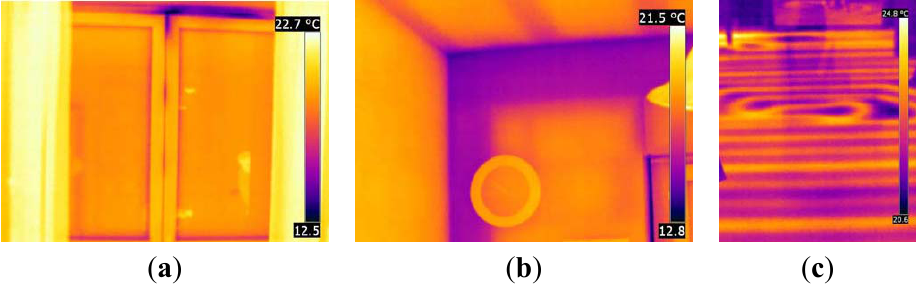
Figure 6. Infrared images of monitored buildings. ( a ) Windows; ( b ) Thermal